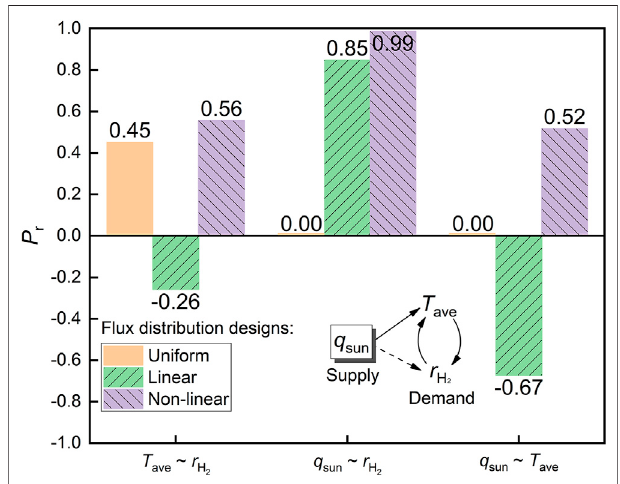
FIGURE 8 | Comparison of the correlation coef fi cient between fi eld variables.